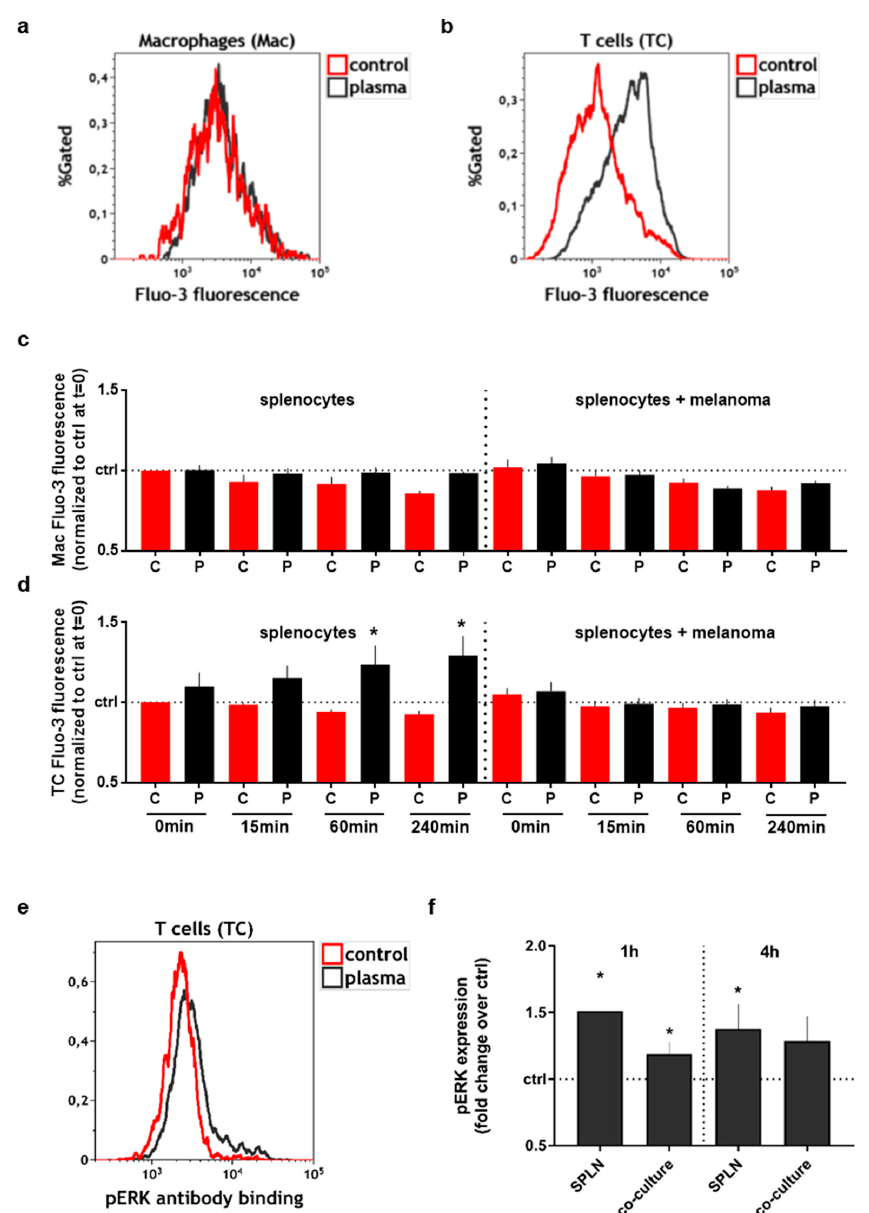
Figure 3. Activation of selected splenocyte subpopulations after co-cultivation with 120 s plasma-cells. ( a ) Representative overlay of calcium release assessed via flow cytometry in macrophages and ( b ) T cells, respectively; ( c , d ) quantification of calcium release over time in macrophages and T cells, respectively after plasma treatment ( e ) representative overlay of phosphorylated extracellular signal-regulated Kinase-1/2 (Erk1/2) kinase in T cells 1 h as measured via flow cytometry; ( f ) quantification of Erk1/2 phosphorylation in splenocytes with or without co-culture with 120 s plasma-treated melanoma cells after 1 h or 4 h. Data are mean +S.E. of several spleens; c=control, p=plasma,